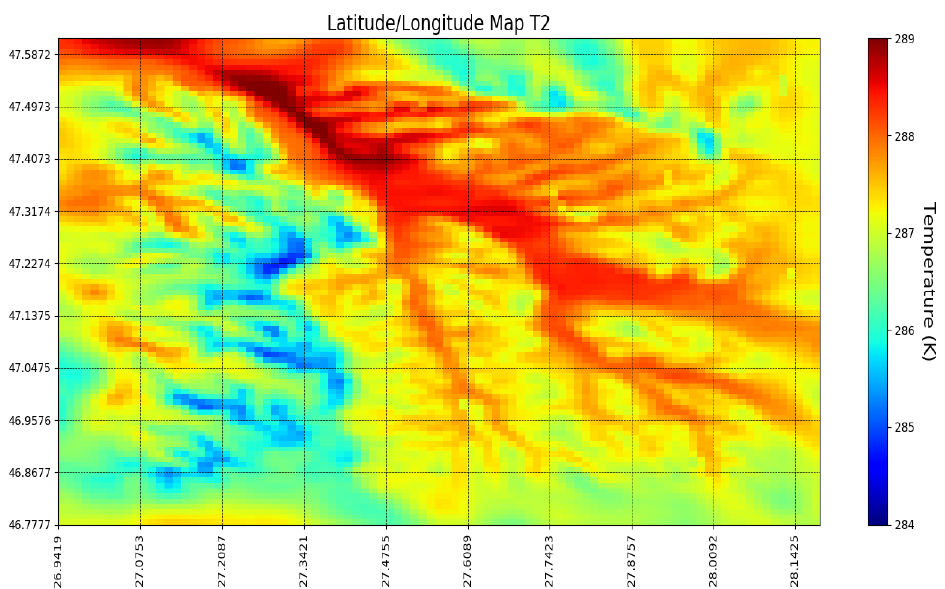
Figure 5 . Example of a WRF output map (temperature at 2 m AGL); 3 rd nest, in center of nest: Ia și ; 17/05/2017, 08:00 UTC; YSU parametrization.